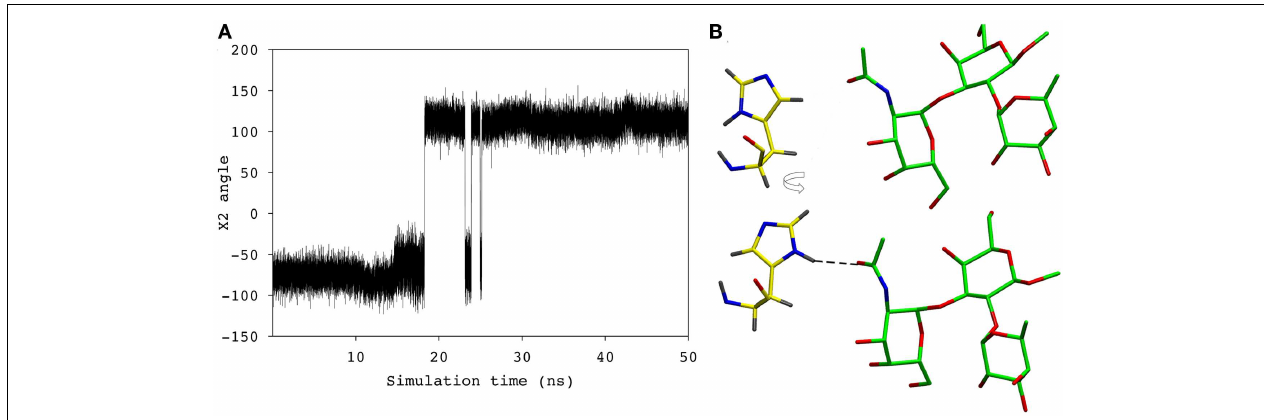
FIGURE 4 | (A) The χ 2 angle of the His L49 during the course of the simulation. (B) His L49 (shown in yellow) during the first 18ns of the simulation (top) and the remainder of the simulation (bottom).